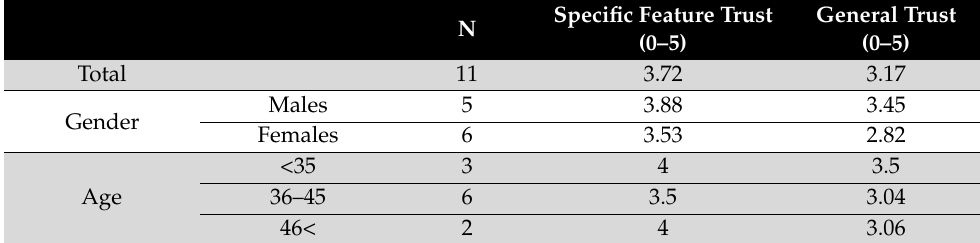
Table 4. Summary of the trust